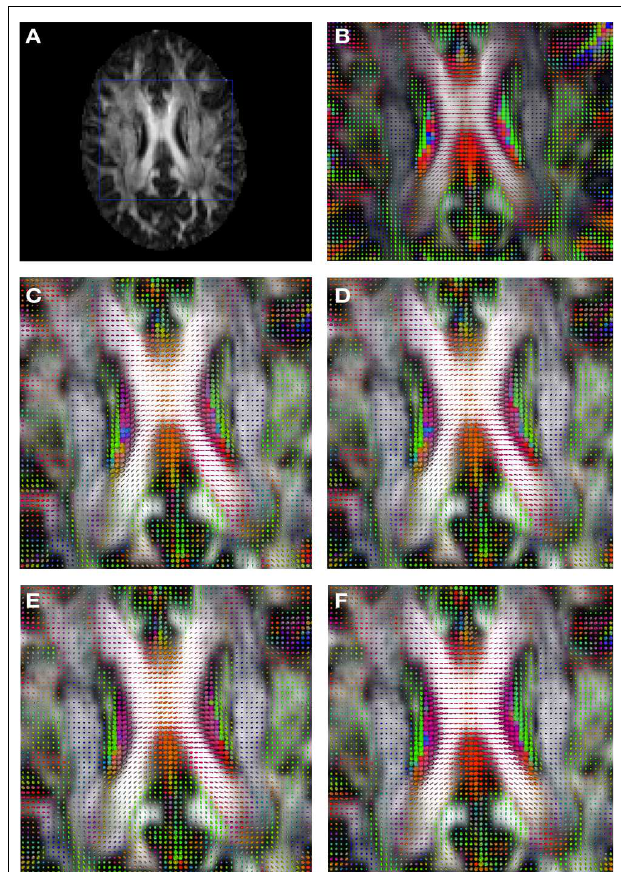
FIGURE 3 | Comparison of the tensors (represented as RGB color coded glyphs) of Subject2 and the registered tensors of a random affine transformation of Subject2. (A) Subject2 FA indicating the region selected to show the tensors. (B) Subject2 tensors. Registered tensors using (C) FLIRT-volumes-SH, (D) FLIRT4D-AI, (E) MedINRIA-volumes-SH, and (F)